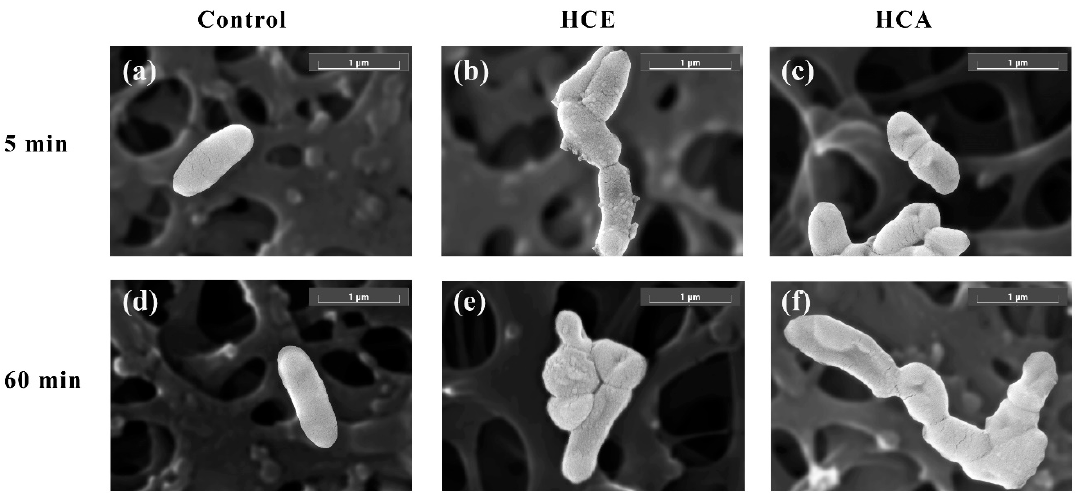
Figure 1. SEM images of C. acnes after incubation with H. cordata extracts at 10 × MICs for 5 min and 60 min. Control cells were treated without any sample for 5 min ( a ) and 60 min ( d ). Bacterial cells were treated with HCE or HCA for 5 min (( b ) or ( c )) and 60 min (( e ) or ( f )), respectively.